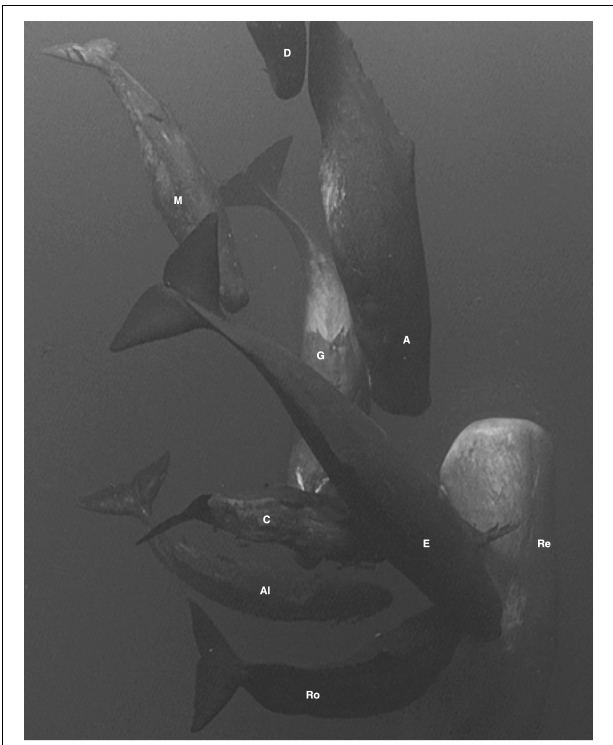
FIGURE 1 | Social interactions between an adult male (Reza, Re), an adult female (Germine, G) and different immatures of the Irène’s group: Eliot (E) 8 years-old; Arthur (A) and Romeìo (Ro) 6 years-old; Ali (Al) Daren (D) and Chesna (C) 1 year-old, and Miss Toutou (M) 3